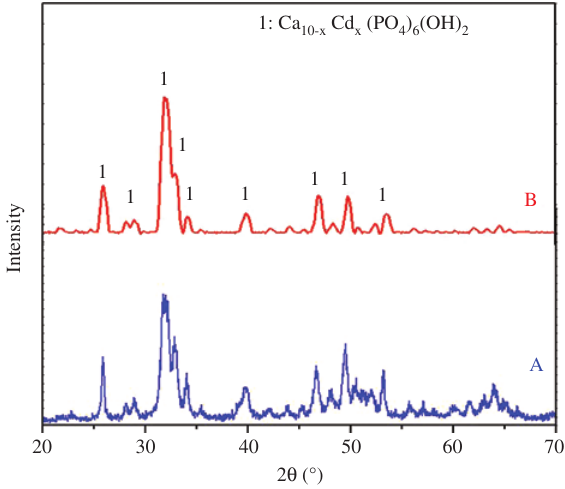
Figure 8: XRD patterns of HAp (A) before and (B) after Cd 2 +